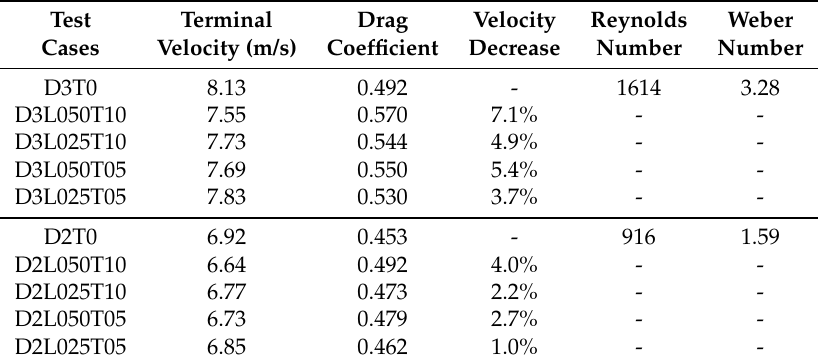
Table 3. Comparison of the terminal velocities and drag coefficients for the 3 mm and 2 mm water drops in turbulent and stagnant air flows.